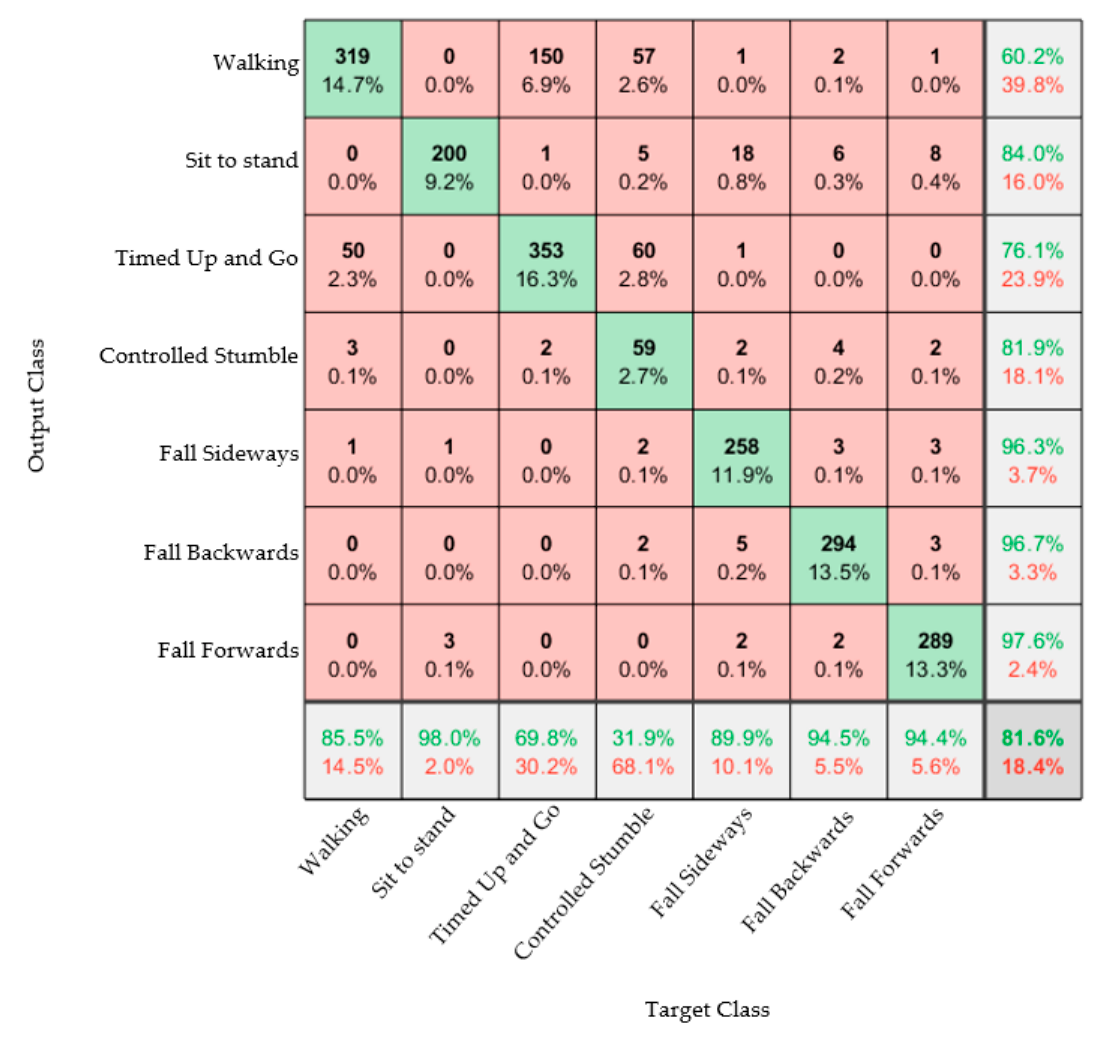
Figure 5. Confusion matrix classifying all of the activities performed for the data collected from all of the participants.